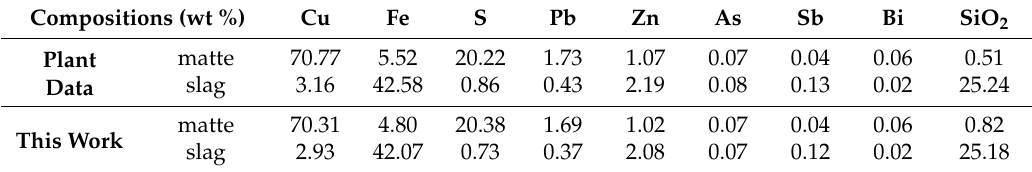
Table 7. Comparison of predicted data with actual plant data of matte and slag compositions in SKS process.